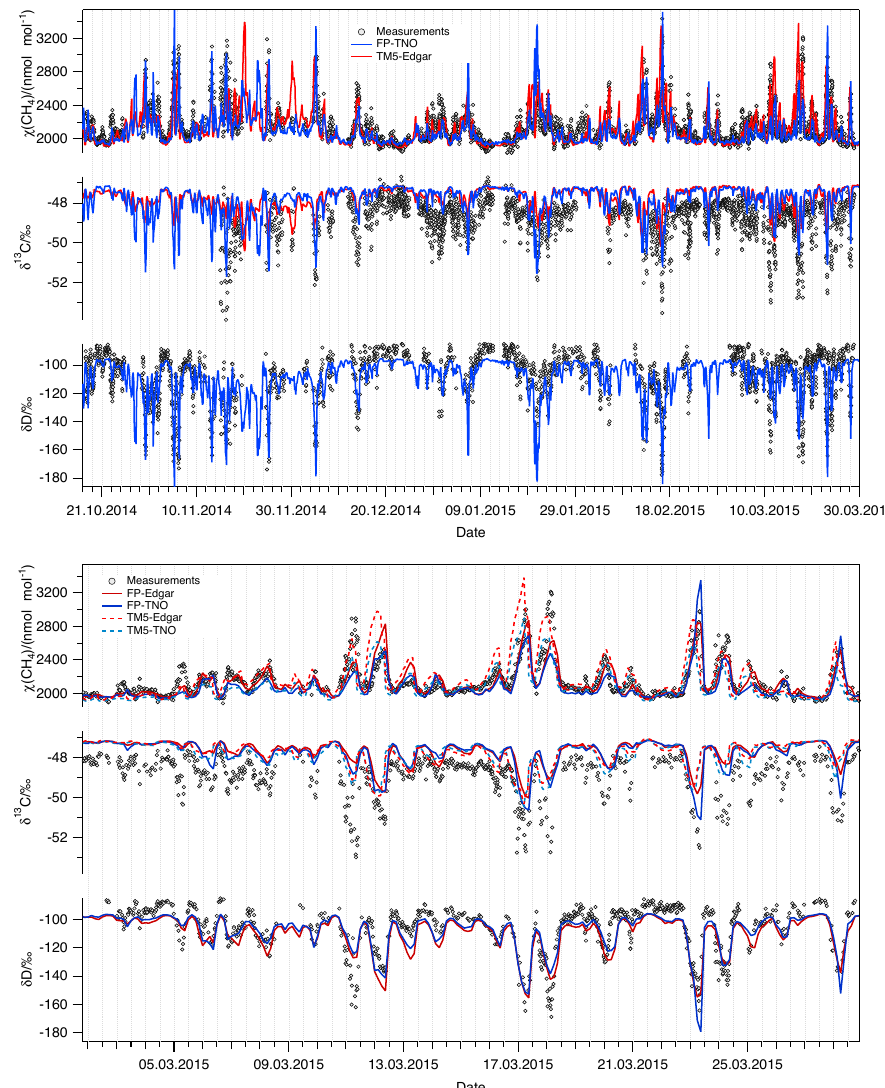
Figure 5. Comparison of the modeled and measured time series of CH 4 mole fraction and isotopic composition ( δ 13 C and δ D). Measurements are shown as circles and model results as lines. The top graph shows two selected model configurations for the entire campaign: FLEXPART- COSMO using the TNO-MACC inventory (blue) and TM5 using the Edgar/WHyMe inventory (red). The bottom graph shows time series for March 2015 with all four model–inventory combinations. For δ D, only the synthetic FLEXPART-COSMO results are available for comparison since TM5 does not simulate δ